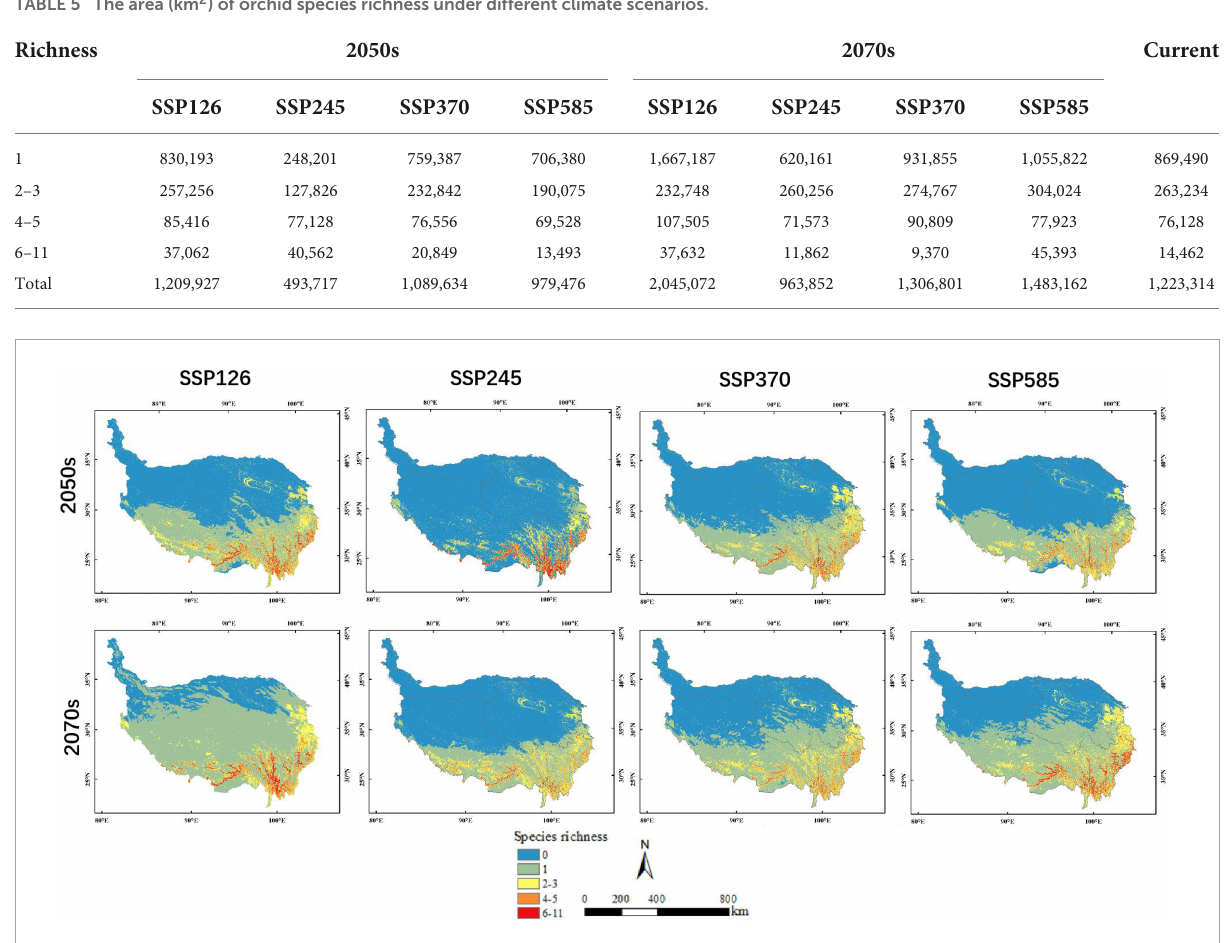
FIGURE4 Prediction results for potential orchid species richness under different climate scenarios in the 2050s and 2070s.